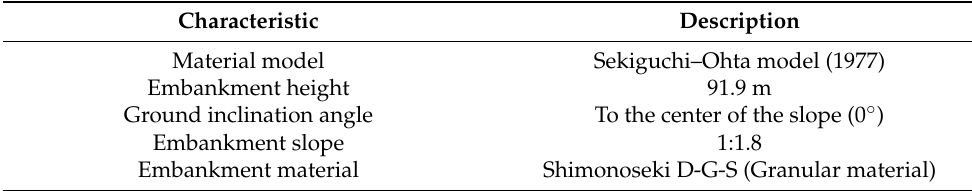
Figure 9. Cross-sectional view of the embankment used in the finite element analysis. Table 3. Characteristics of the embankment model used in the finite element analysis.